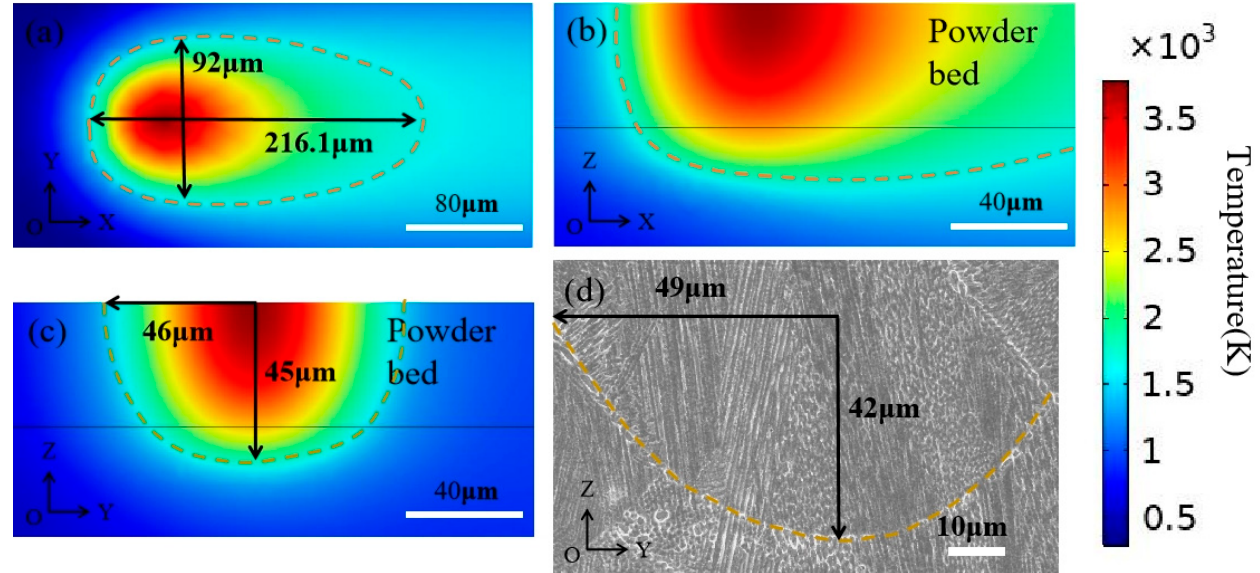
Figure 6. Model verification. ( a ) Temperature field simulation results of the XOY section; ( b ) Temperature field simulation results of the XOZ section; ( c ) Temperature field simulation results of the YOZ section; ( d ) Morphology of the molten pool in the experiment.